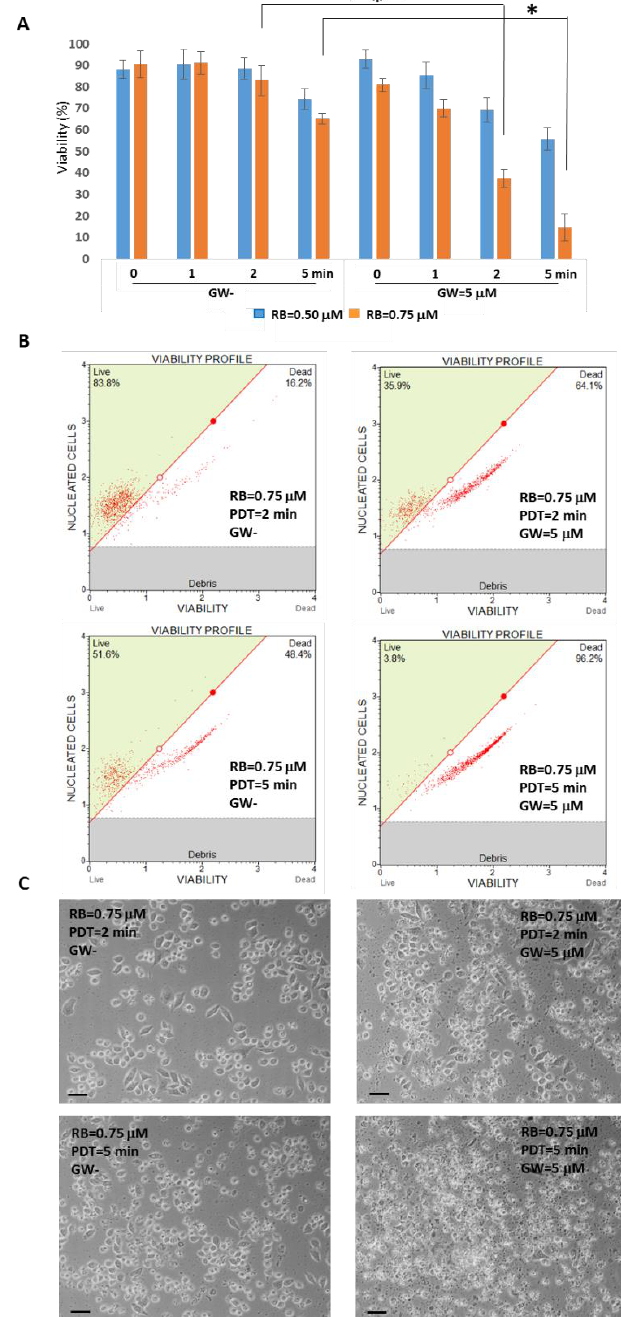
Figure 9. Viability assays following RB starvation, PDT exposition and GW4869 administration in T98G cells. ( A ) Cytofluorimetric viability graph of T98G cells ( n = 2000) incubated with RB concentrations (i.e., 0.50 and 0.75 μ M) for 30 min in HBSS media, with or without GW4869 (GW = 5 μ M), combined with different PDT exposition times (i.e., 0 – 1 – 2 – 5 min at 562/576 nm), after 24 h in standard growing conditions (high glucose media). Asterisks indicated statistical significance compared to GW cells ( p < 0.05, ANOVA one-way; SD are highlighted as vertical bars). ( B ) Examples of cytofluorimetric viability plots and ( C ) optical microscope examinations of RB (0.75 μ M), with/without GW4869 and PDT (2 – 5 min at 562/576 nm). Scale bars = 30 m. The established protocol, RB = 0.75 μ M administered for 30 min in HBSS starvation, followed by PDT exposition of 2 min at 562/576 nm, administration of GW 5 μ M, in the presence of reconditioning standard medium for 24 h, was comparatively analyzed for